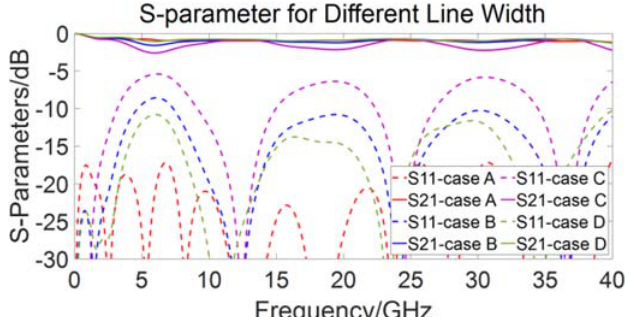
Fig. 3. S-parameters for SSPP TLs with different line widths w 1 and w 2 for different layers. Case A ( w 1 = 1.64 mm, w 2 = 0.76 mm), Case B ( w 1 = 1.64 mm, w 2 = 1.20 mm), Case C ( w 1 = 1.64 mm, w w w 2 = 1.64 mm), Case D ( 1 = 1.20 mm, 2 = 0.76 mm). (The depths of the SSPP units proportionally change with the line widths).